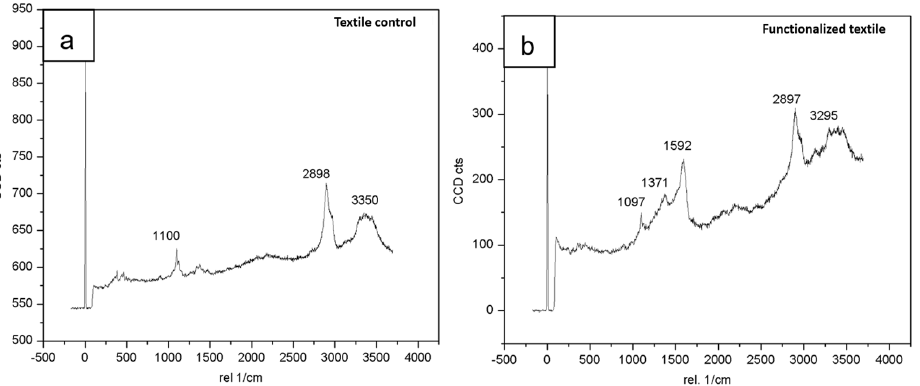
Figure 6. Raman spectrum of the control ( a ) and functionalized ( b ) fabric with AgNPs-CMC nano- composite.